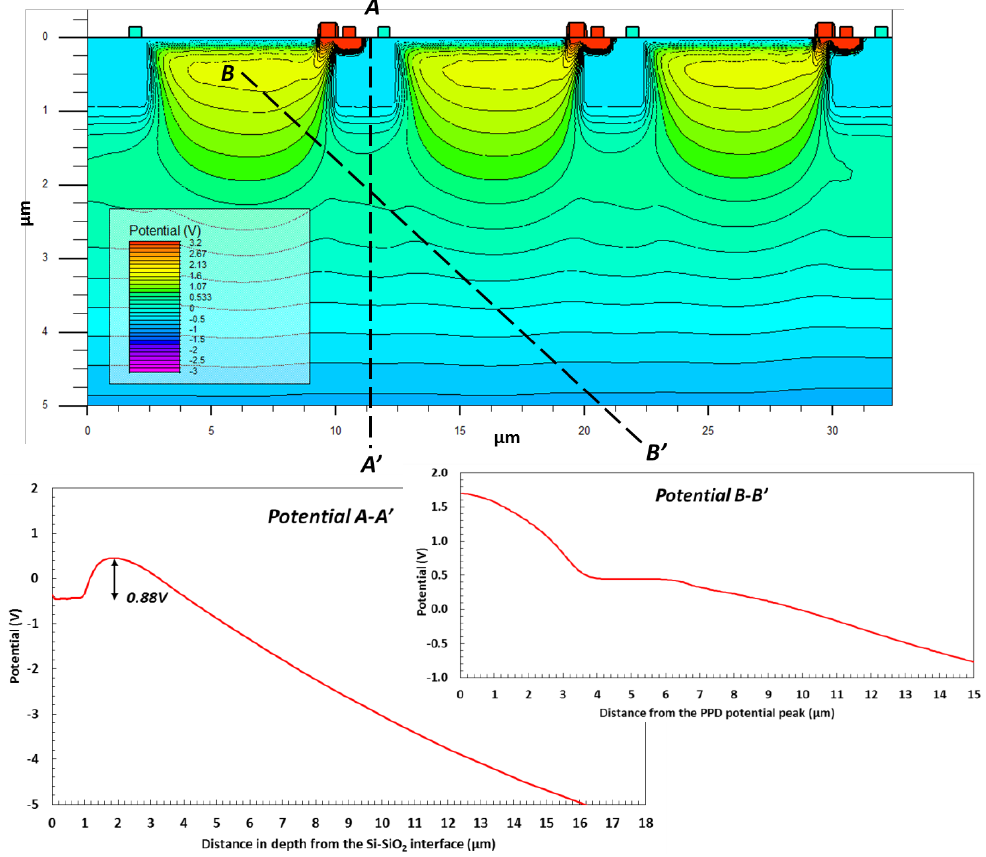
Figure 3. Potential distribution in a 2D simulation model reverse biased at −5 V, and the potential profiles along two lines: A–A’ is a vertical line crossing a p-well perpendicular to device’s surface; B–B’ starts from the potential peak in the PPD at 0.45 µm below the surface and cuts through the middle of the DDE implant. The two lines intersect at 2 µm along A–A’ and 5.25 µm along B–B’. The simulation is for 1000 Ω·cm, 18 µm thick epitaxial silicon and 10 µm pixels.